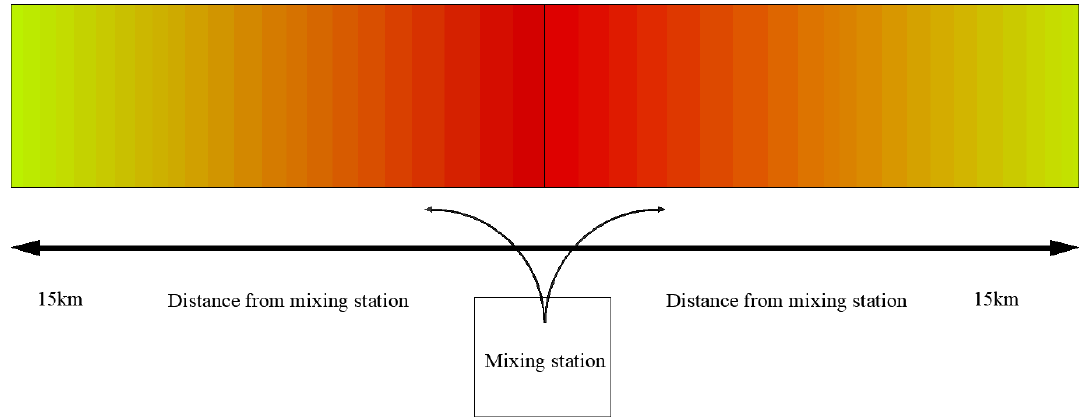
Figure 6. Distribution of load times. Red indicates that the number of vehicles under full load is high, whereas the yellow indicates the number of vehicles under full load is low. Table 4. Frequency of loading trucks.